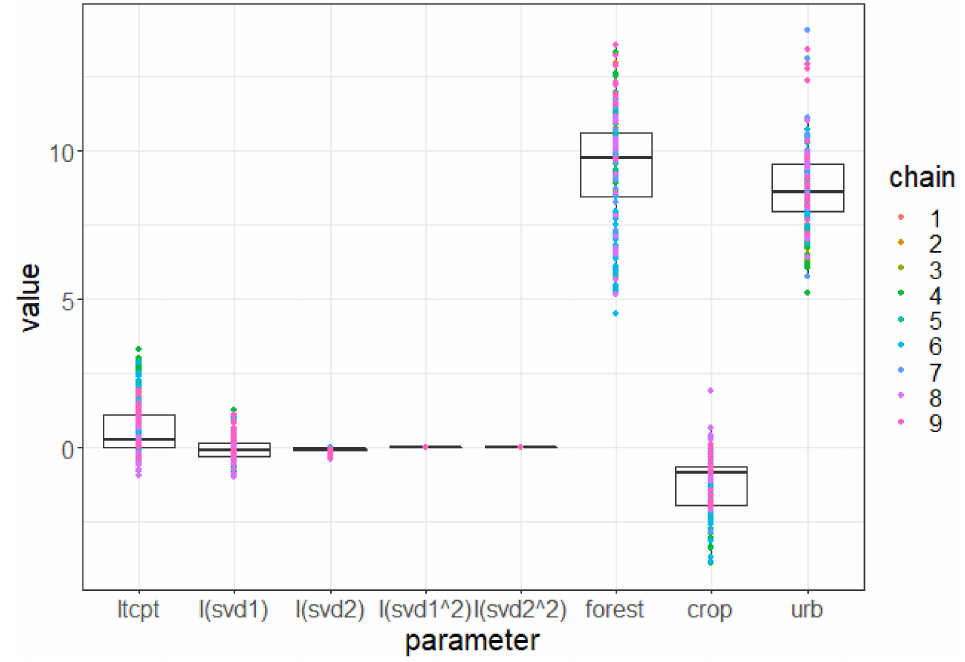
Figure A8. Box plot of environmental suitability parameter posterior distribution. For each com- ponent of β , we summarize the posterior sample values in a box plot. Each colored point cor- responds to an MCMC chain and iteration consistently with other figures. I(svd1) and I(svd2) are the components associated with the 2 synthetic bioclimatic axes (see section Environmental variables— Bioclimatic variables of the main manuscript), while I(svd1ˆ2) and I(svd2ˆ2) are associ- ated with their quadratic